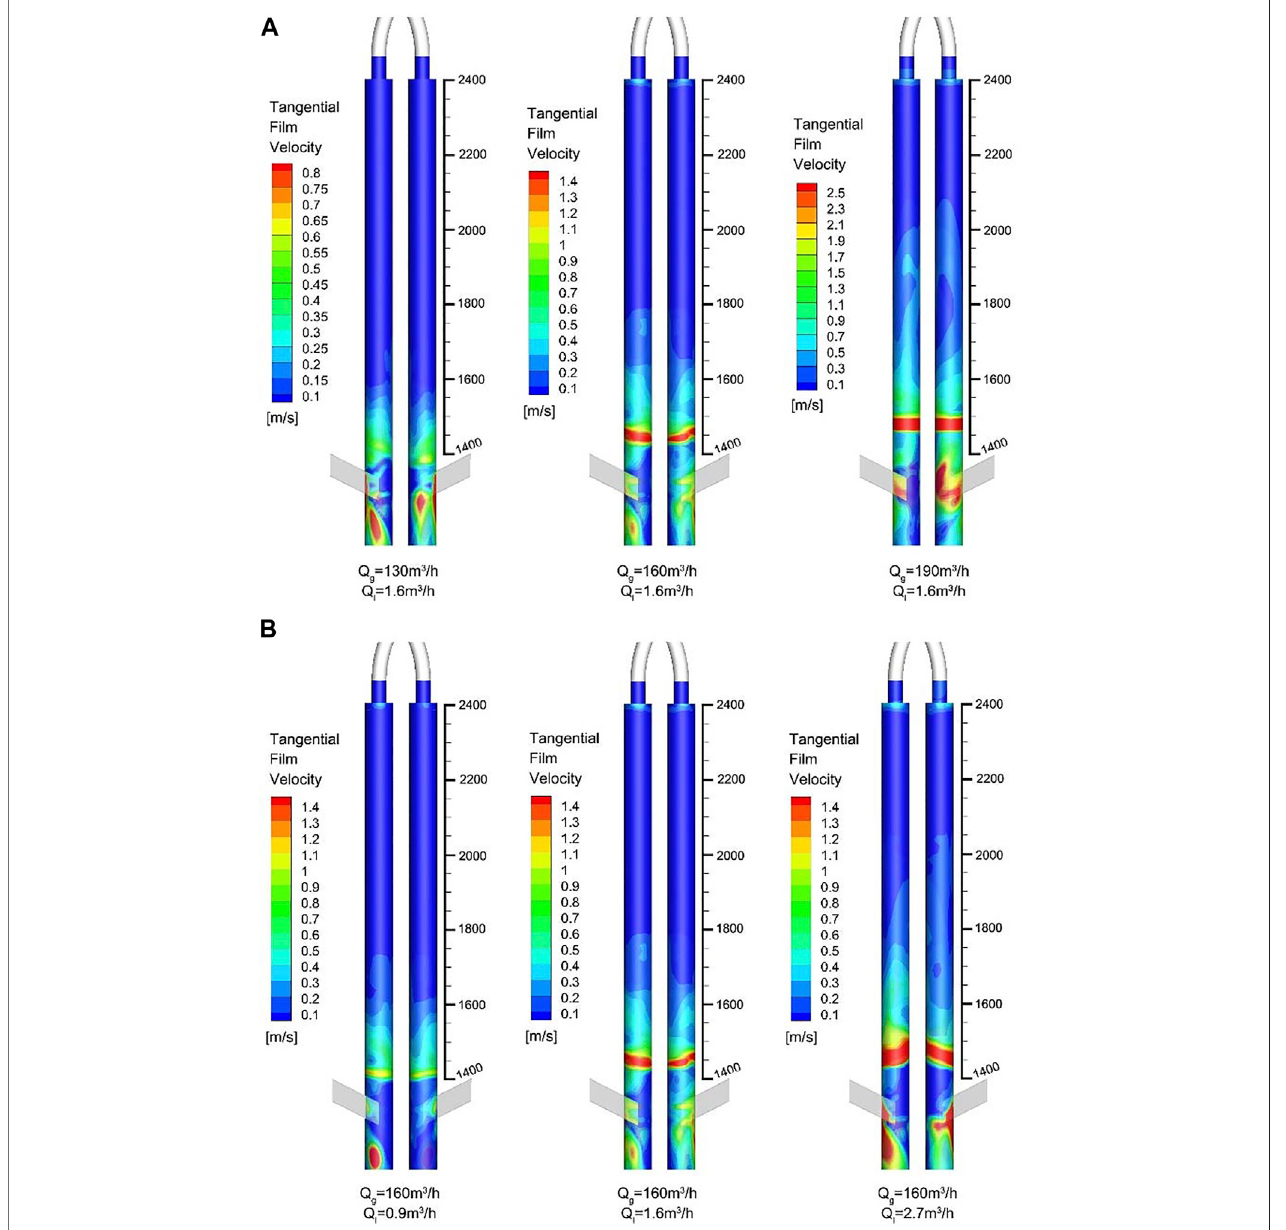
FIGURE 11 | Contours of USLF axial fi lm velocity under different (A) gas fl ow rates and (B) liquid fl owrates.